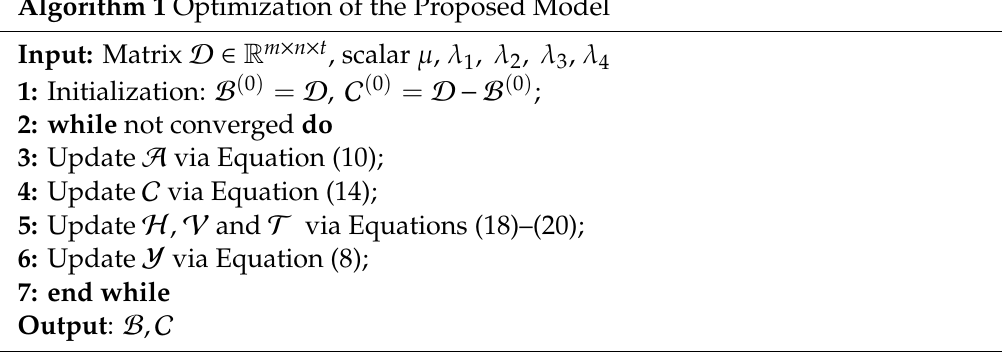
Algorithm 1 Optimization of the Proposed